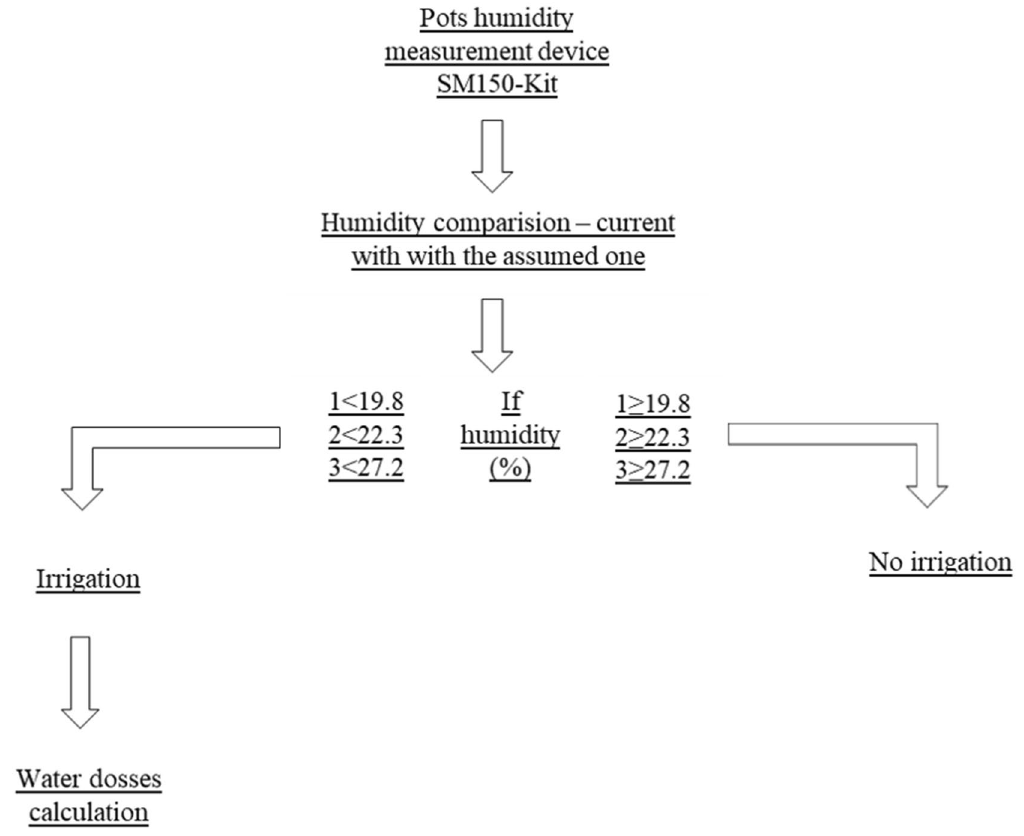
Figure 2. Procedural diagram for determining water irrigation